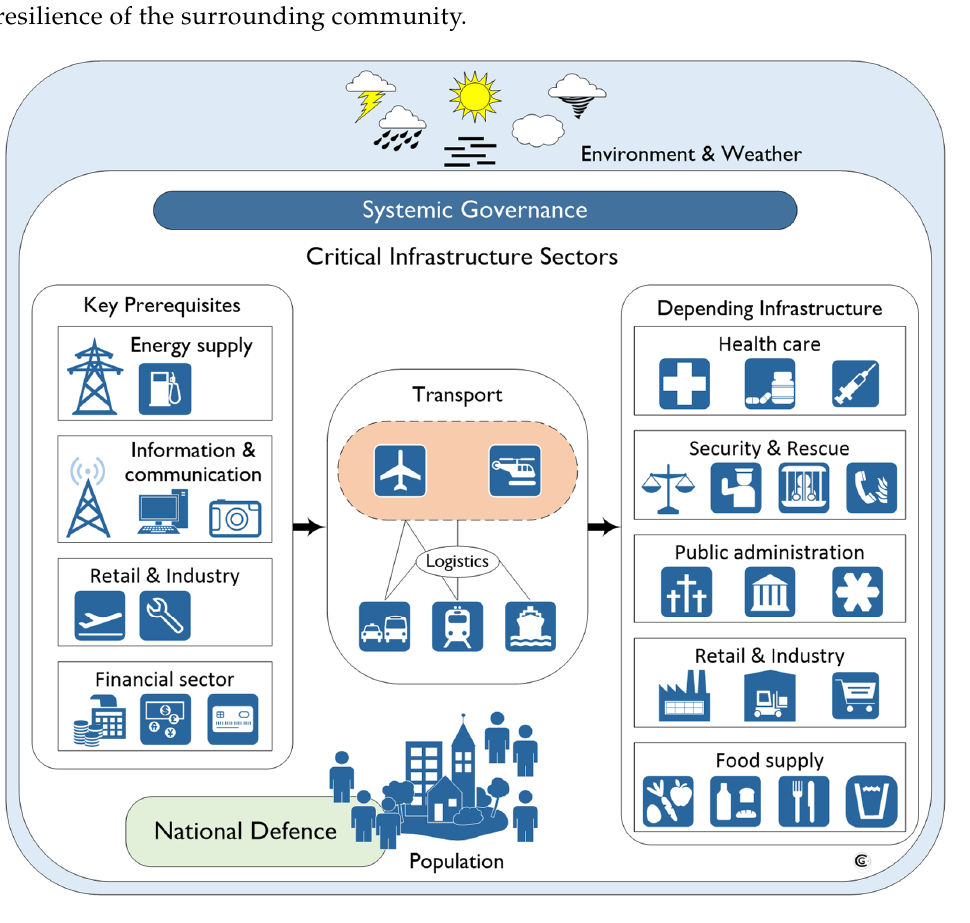
Figure 4. Relationships between sectors of critical infrastructure.